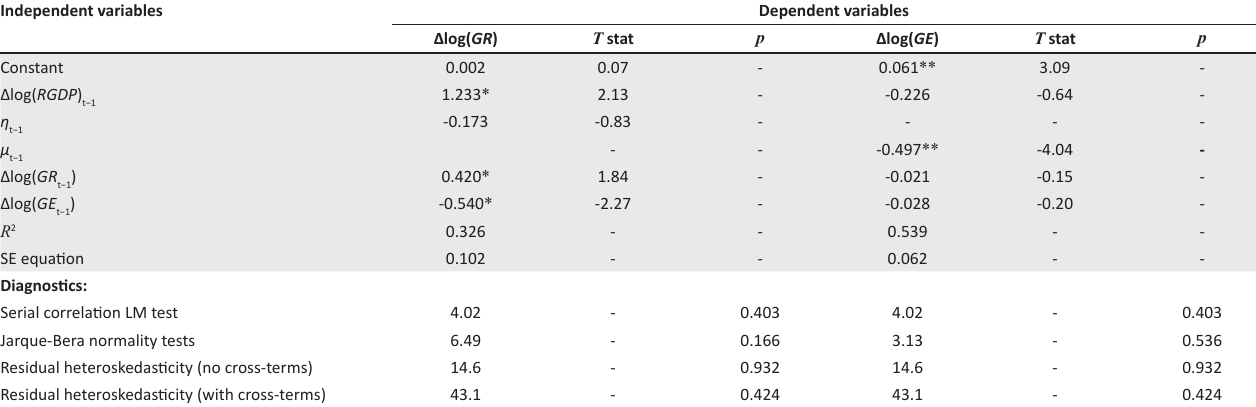
TABLE 11: Vector error correction model